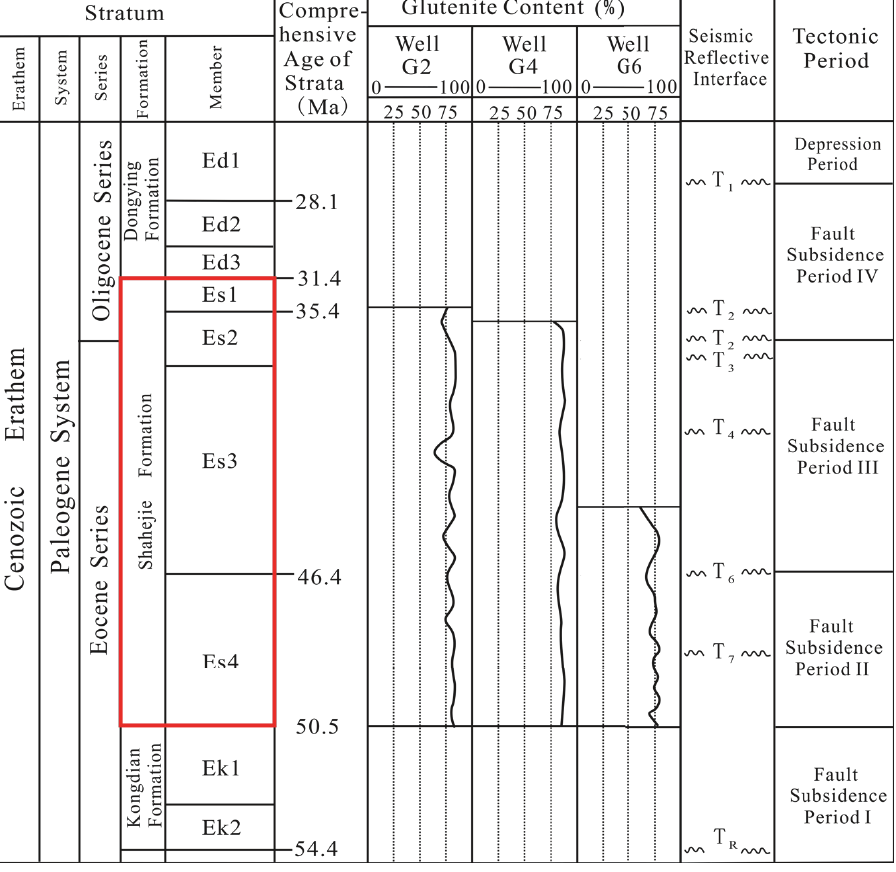
Figure 2. Stratigraphic development characteristics (Es1, Es2, Es3, and Es4 are short for members 1, 2, 3, and 4 in Shahejie Formation